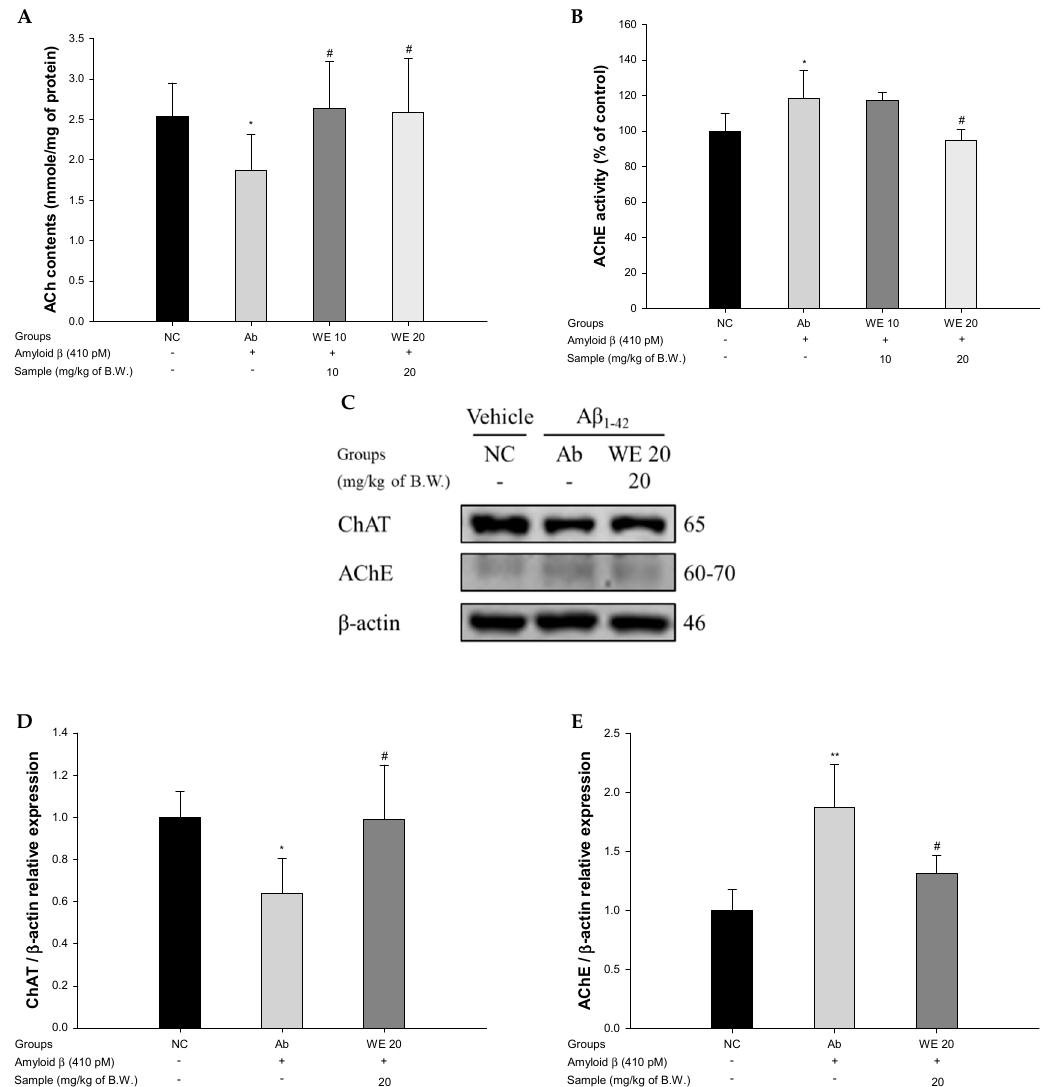
Figure 5. Protective effect of walnut ( Juglans regia L.) extract on A β -induced cholinergic dysfunction. ( A ) acetylcholine (ACh) levels, ( B ) acetylcholinesterase (AChE) activities, ( C ) protein expression levels, ( D ) representative Western blots for the total protein and expression of choline acetyltransferase (ChAT) in mice brain tissues, and ( E ) representative Western blots for the total protein and expression of AChE in mice brain tissues. Results shown are means ± SD (A,B: n = 5; C–E: n = 3). Data are statistically represented at * = significantly di ff erent from the NC group; # = significantly di ff erent from Ab group; * and # p < 0.05, ** p <